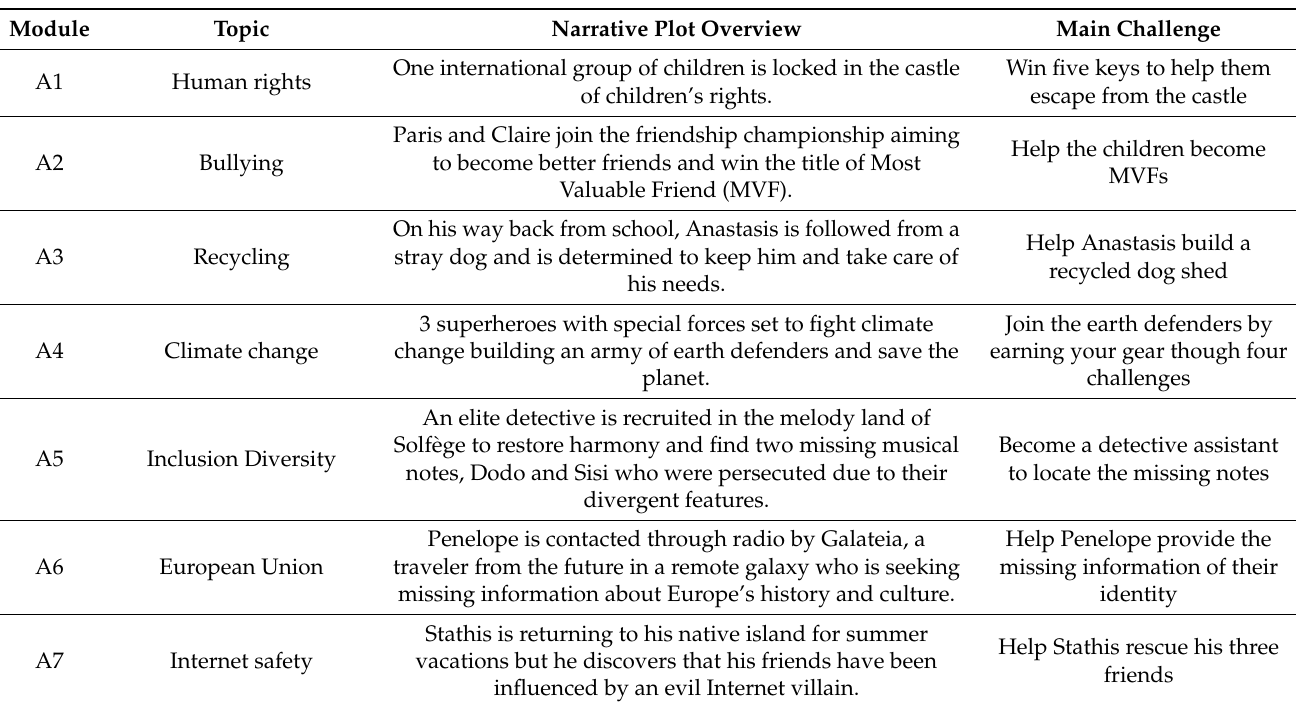
Table 2. Narratives of playful e-learning